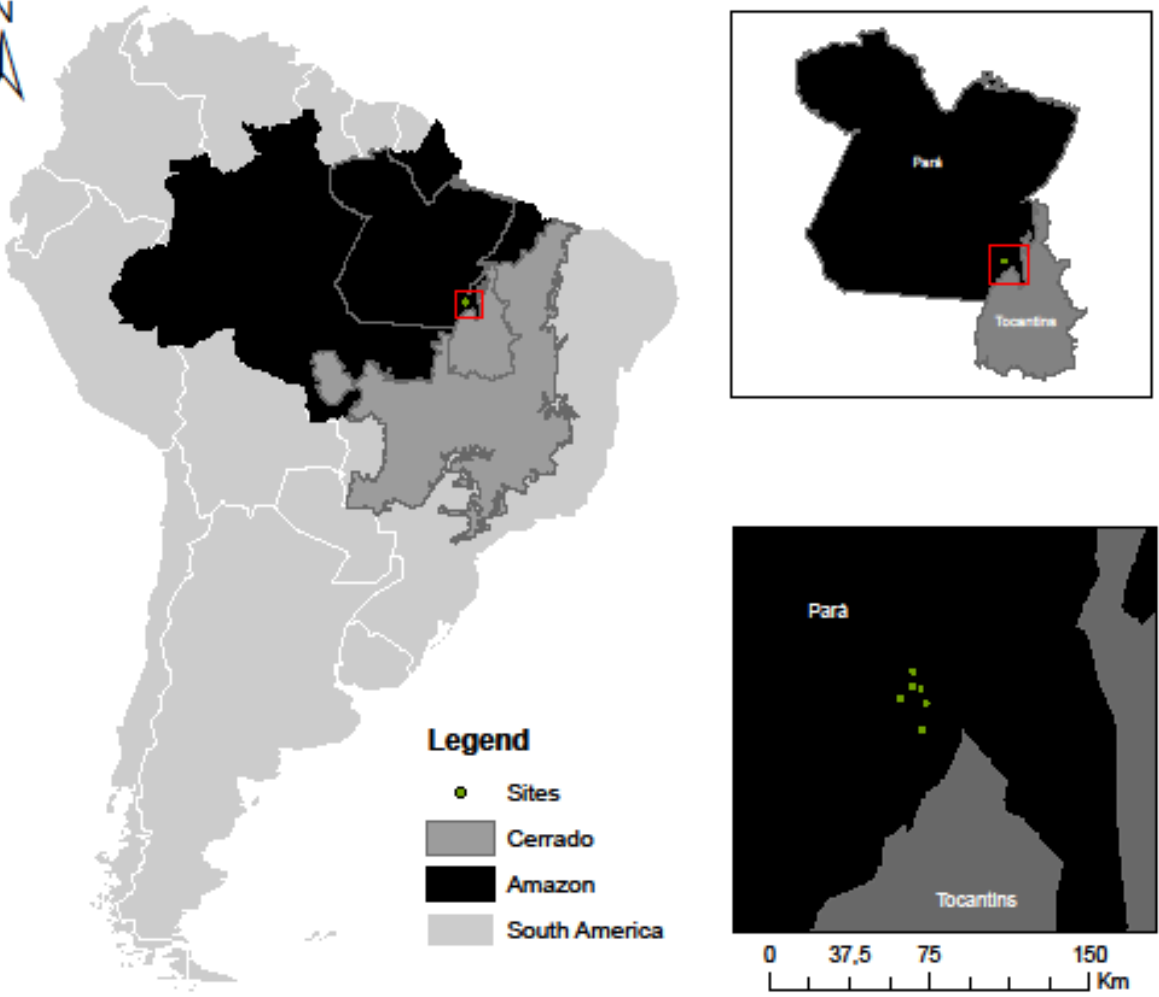
Fig 1 . Location of the six bee collecting areas in a Cerrado and Amazon Forest ecotone in the municipality of Conceição do Araguaia, southeast of Pará,